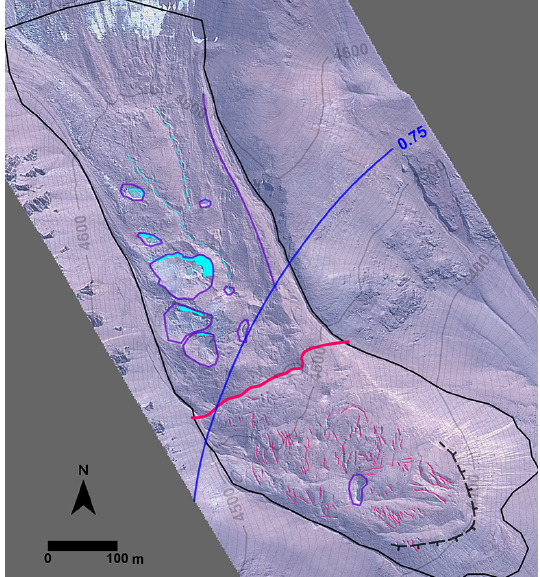
Figure 5. Map of the Las Tetas landform. See Fig. 2 for legend. The background of the map is the 2012 Geoeye image draped over the Geoeye DEM (see the “Material and methods” section).